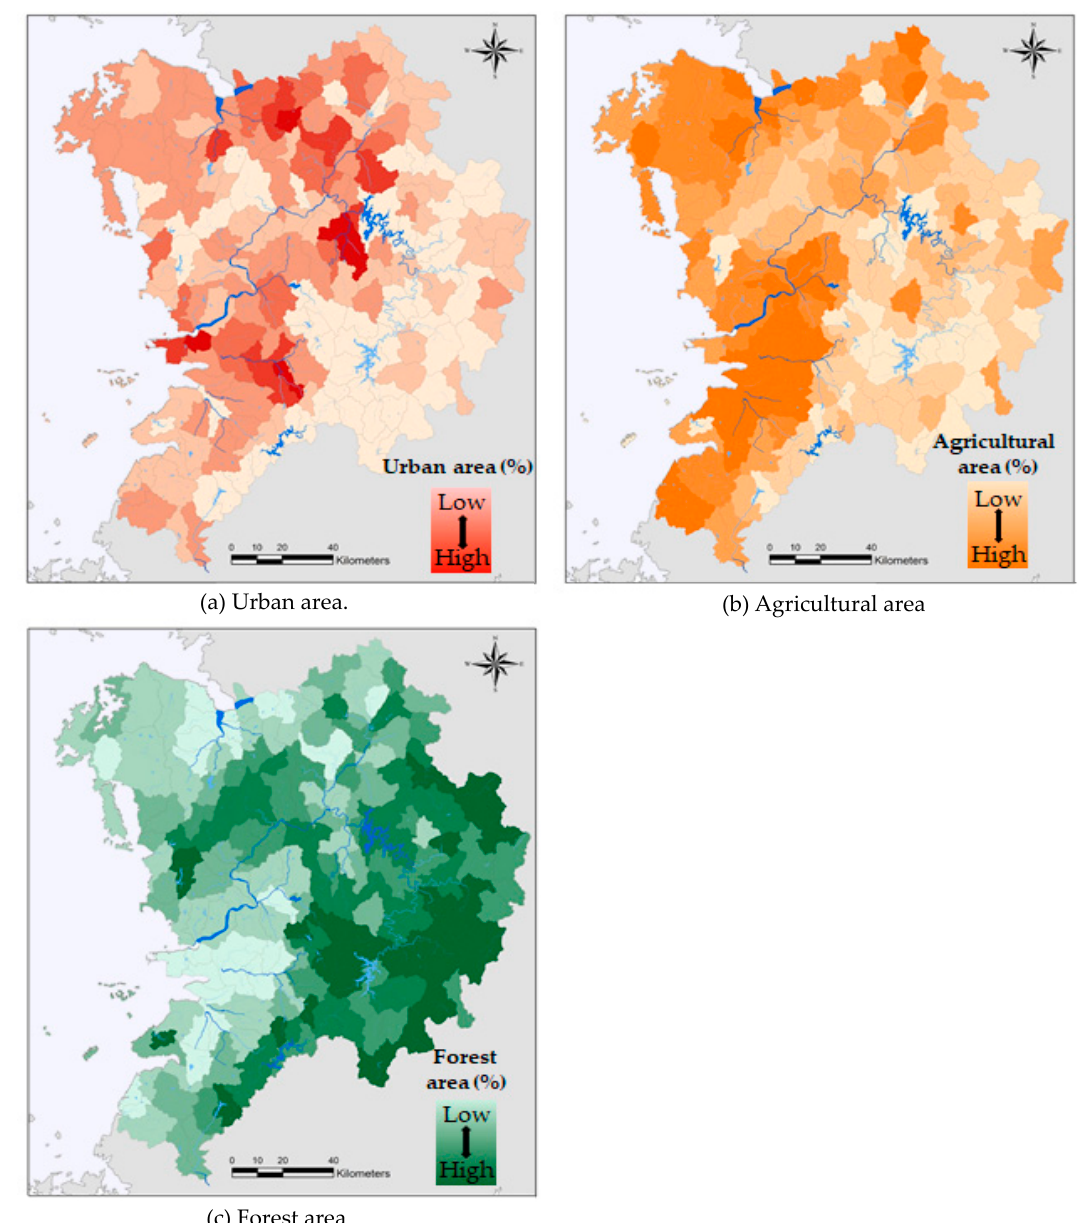
Figure 2. Spatial distribution of urban, agricultural, and forest areas (%) in the study area.